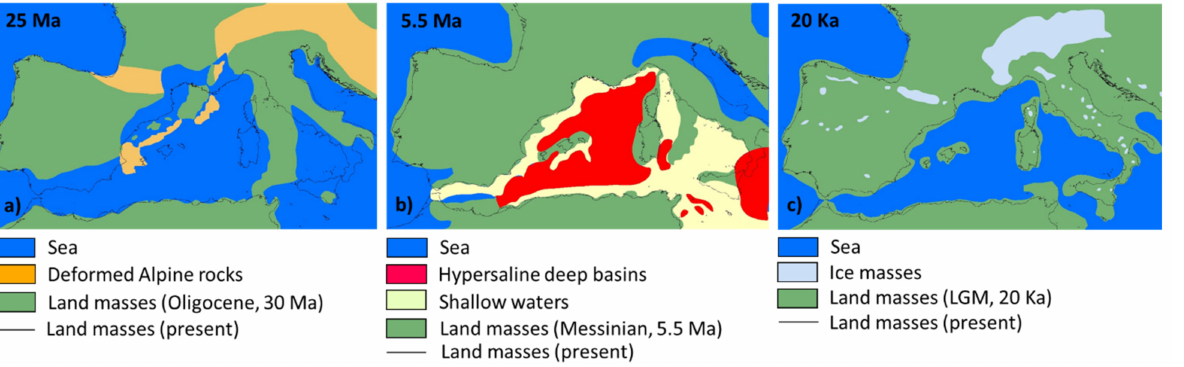
Figure 3. Palaeogeographical maps of the western Mediterranean Basin during the three main episodes that explain the current patterns of Sardinian plant distribution and their biogeographical links: ( a ) the backward migration of the ‘Hercynian islands’ during the Oligocene (ca. 30–15 Ma), redrawn after [4,133]; ( b ) the Messinian salinity crisis due to the closure of the Mediterranean–Atlantic gateways during the Late Miocene (ca. 6–5 Ma), redrawn after [28,134]; and ( c ) the climatic and eustatic changes of the Pleistocene, occurred from Early Pliocene (ca. 5 Ma) until the Last Glacial Maximum (LGM, ca. 20,000 years ago), redrawn after